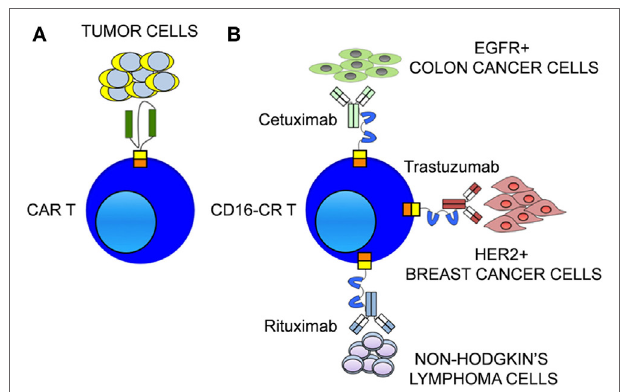
FiguRe 2 | Therapeutic monoclonal antibodies (mAbs) confer to CD16-CR T cells multiple target specificities . (A) The ability of chimeric antigen receptor (CAR) to redirect T cells toward tumor cells is restricted to a single tumor-associated antigen (TAA) expressed on tumor cell surface. (B) The availability of therapeutic mAbs allows CD16-CR to redirect T cells virtually against all TAA expressed on a variety tumor types including hematological and epithelial